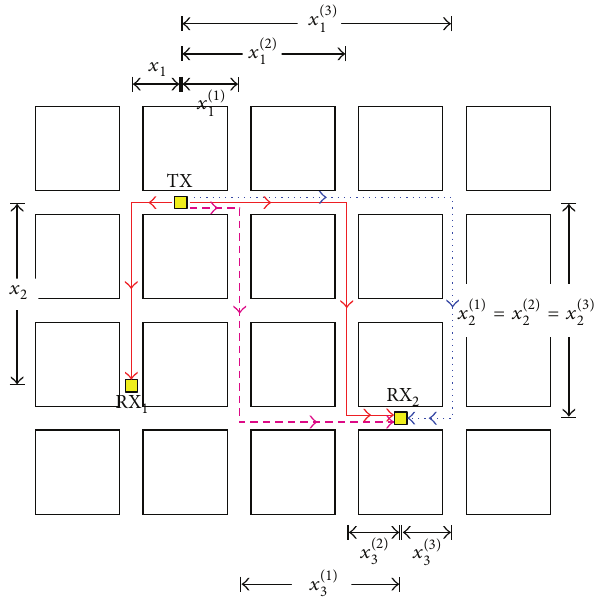
Figure 6: 1-Turn (between TX and RX 1 ) and 2-Turn (between TX andRX 2 )NLOSexamples:the1-TurnNLOShasasinglepropagation path while the 2-Turn NLOS has 3 comparable propagation paths.